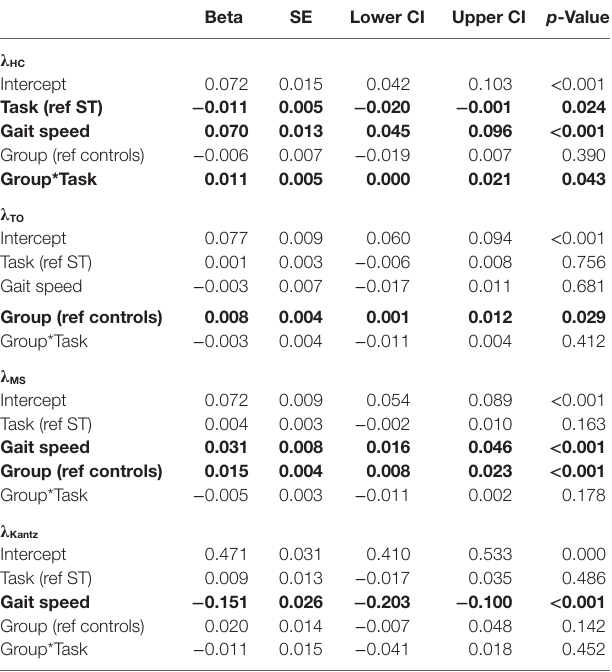
Lower and upper 95% confidence intervals (CI) for beta are also presented. Bold values indicate significant effects at p < 0.05.